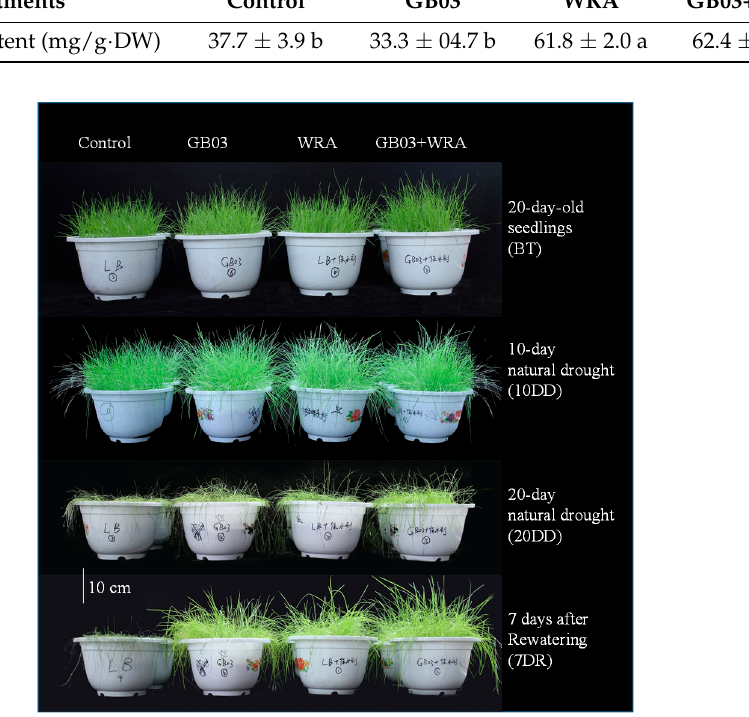
Figure 1. Ryegrass growth status of different treatments in four vegetation phases. From left to right: control, GB03, WRA and GB03+WRA treatments; from top to bottom: 20-day-old seedlings (before treatment, BT), 10-day natural drought (10DD), 20-day natural drought (20DD) and 7 days after rewatering (7DR).